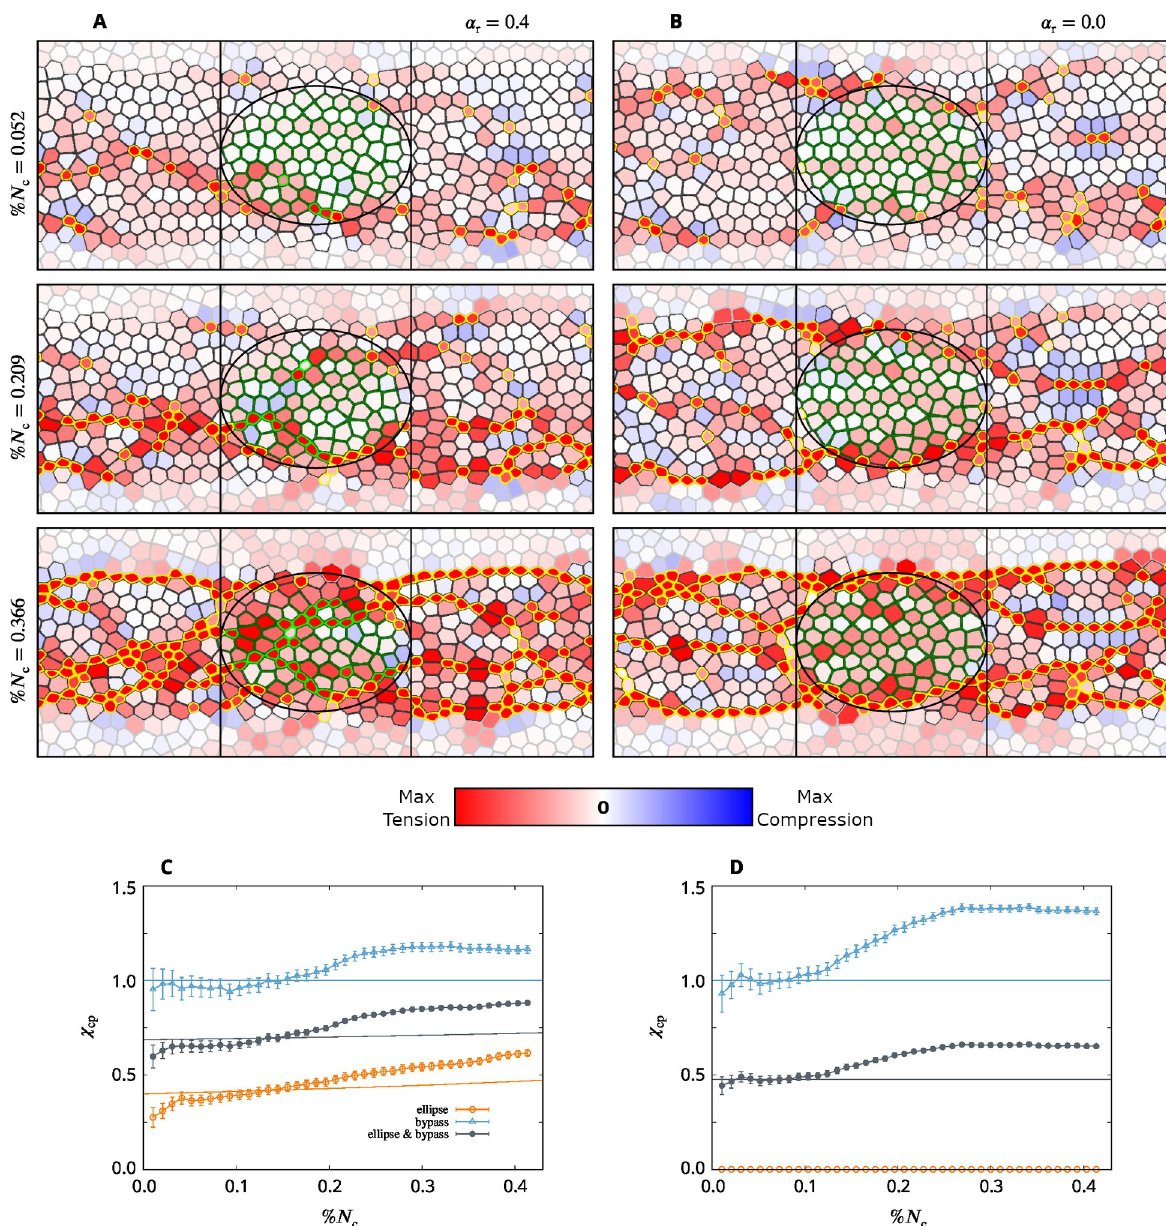
Fig 12. Two modes of constriction rescue for elliptical disrupted domain in a system with tensile feedback. ( A,B ) Time-lapse simulation frames for the AGF system with an elliptic region of cells whose constriction probability is (A) decreased by a factor α r = 0.4 and (B) reduced to zero, α r = 0. Color convention per Fig 10. The disrupted area is indicated by the ellipse. ( C,D ) Corresponding measures of the constriction recovery for the ellipse w ¼ w E (orange), bypass region w ¼ w B (blue), and joint ellipse and bypass region w ¼ w EB (the entire area between the vertical lines; cp cp cp cp cp cp slate). Simulation results for the tensile sensitive system (symbols); exact theoretical results, Eq 18 and Eq 19, for uncorrelated random constrictions (lines). The results show that for the complete probability reduction the constriction recovery in the tensile sensitive system occurs by constriction chains wrapping around the affected ellipse, and for the partial reduction constriction chains both penetrate and wrap around the affected region. Simulations ( n = 120). Error bars: SE.